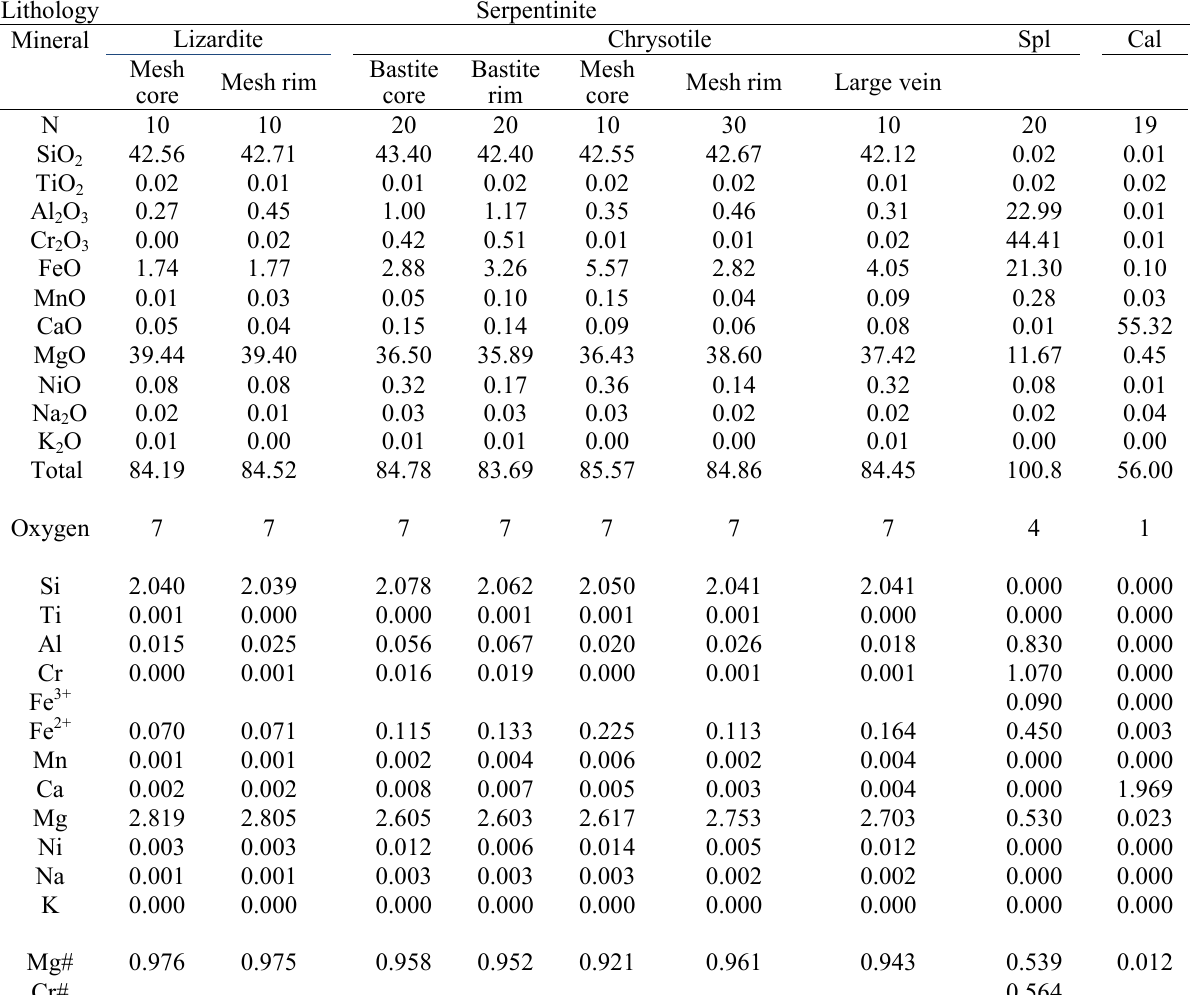
Table 3. Average electron microprobe data (in wt.% ) and calculated structural formulae (in a.p.f.u) for serpentine minerals, spinel, and calcite. Lz = Lizardite, Ctl = Chrysotile, Spl = Spinel, Cal =